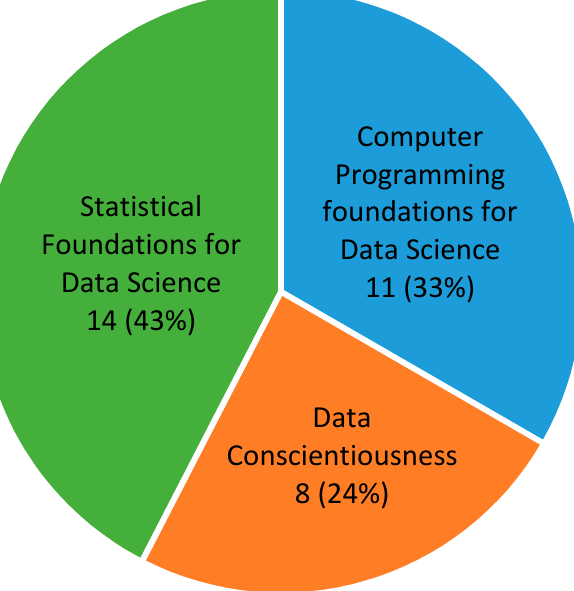
Figure 4. Number of requests for three data science courses offered by SACS.